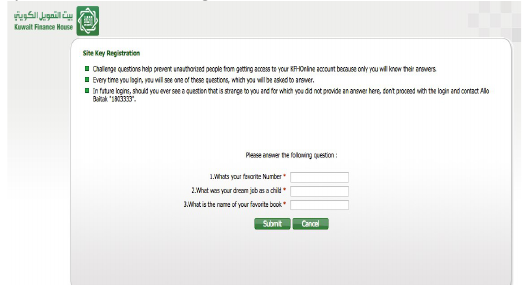
Figure 1-3: Security Questions.